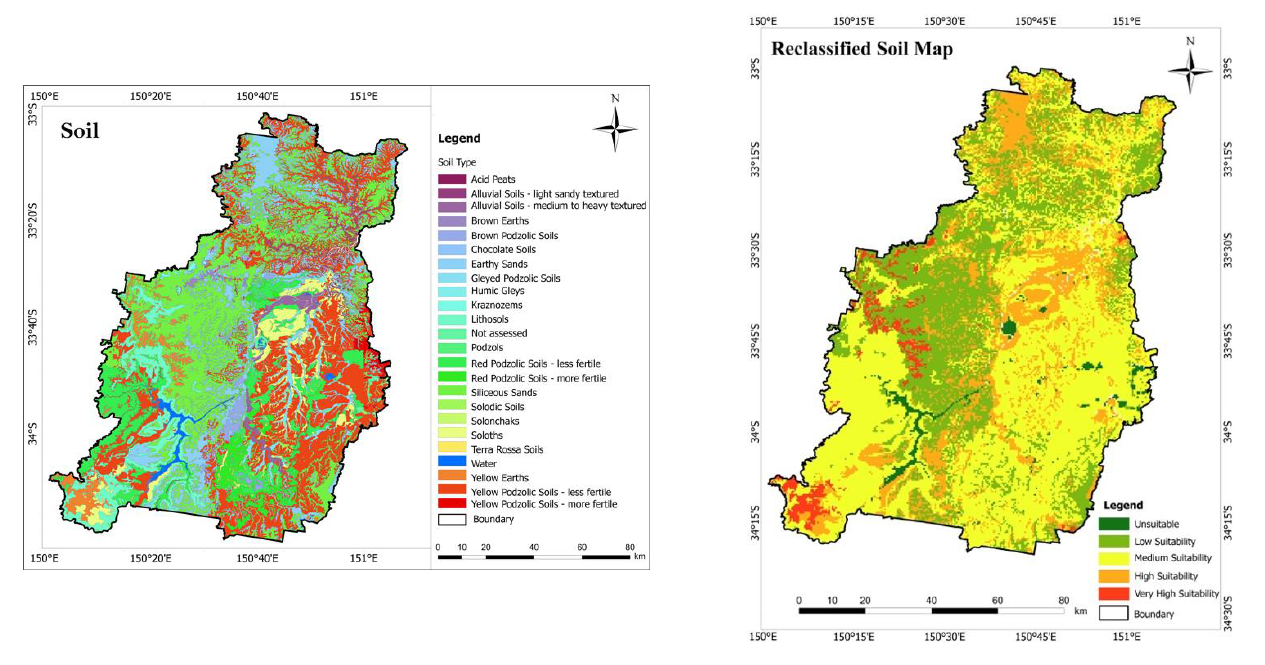
Figure 12. Soil types and reclassified suitability map soil ( left ); reclassified soil ( right ). Table 6. Distribution of soil types of suitability classes.